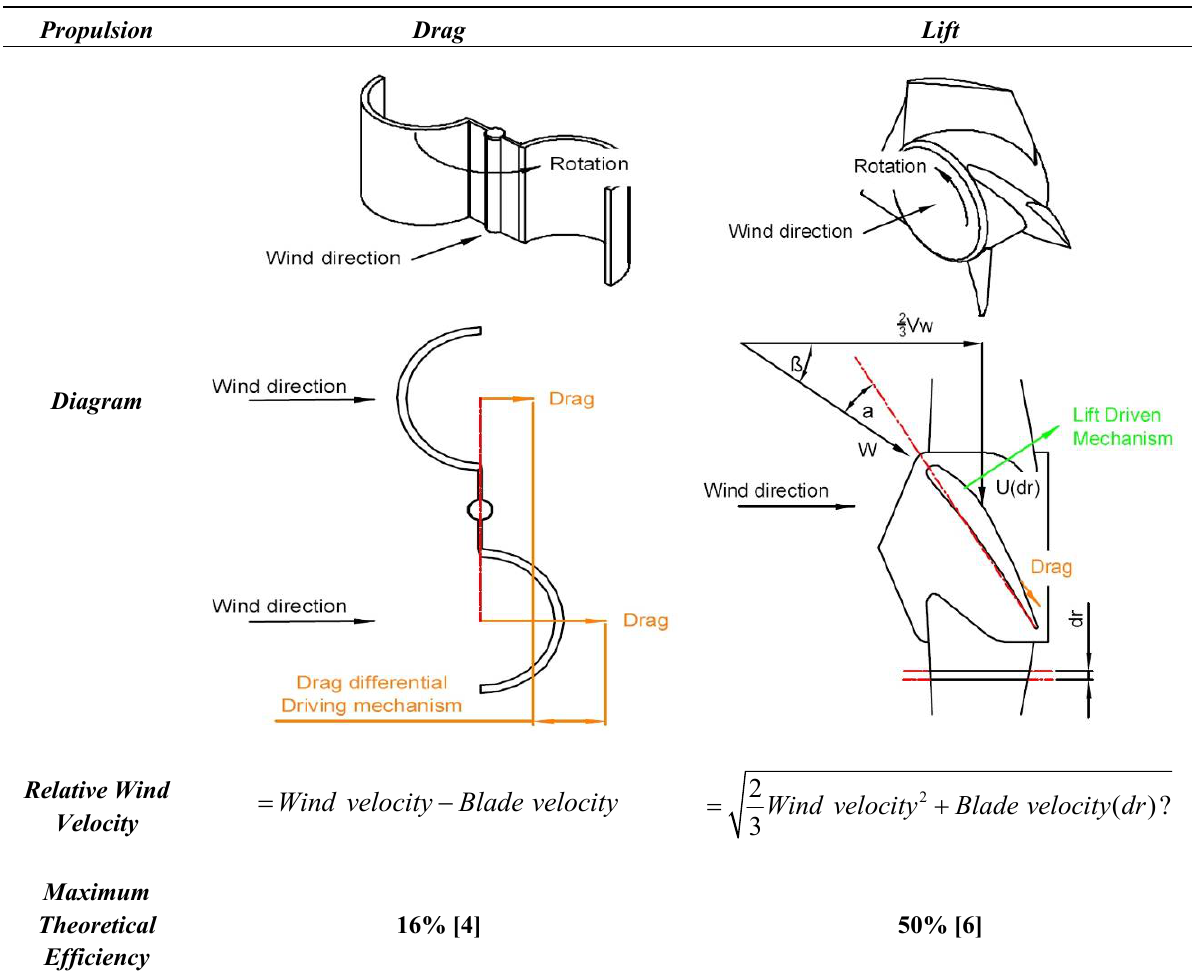
Table 1. The two mechanisms of propulsion